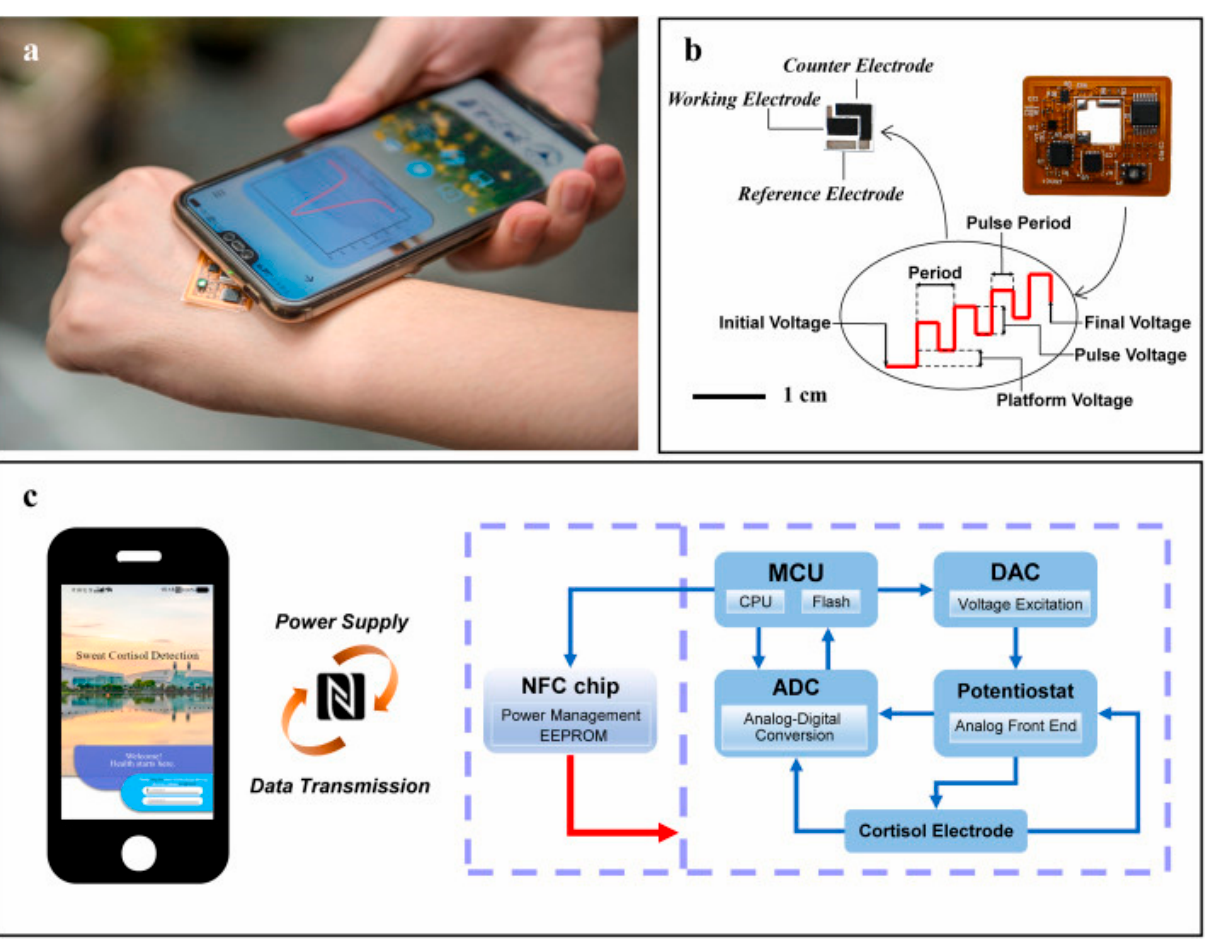
Figure 8. The integrated wireless, battery-free, and flexible detection system with NFC-enabled smartphone. ( a ) An image of in situ detection of sweat cortisol; ( b ) the flexible sensing system for electrochemical detection of cortisol; ( c ) block diagram of the wireless, battery-free, and flexible patch. Reprinted from Ref. [94]. Copyright (2017), with permission from Elsevier.